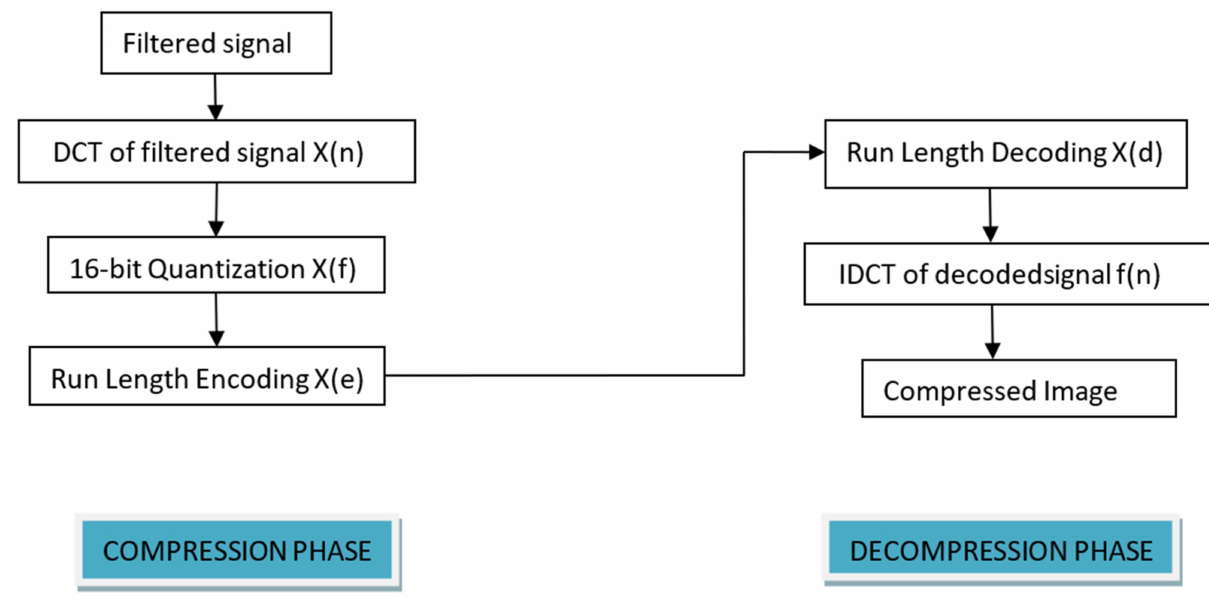
Figure 5. Compression codec of